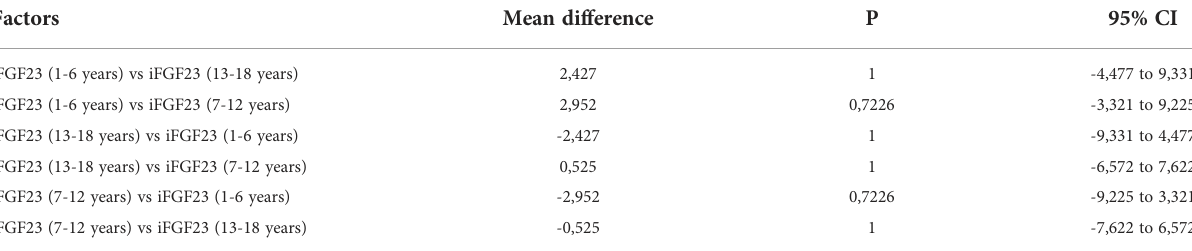
TABLE 6 Multiple comparison procedures (pairwise comparison) in ANOVA test in age-strati fi ed subgroups. Factors